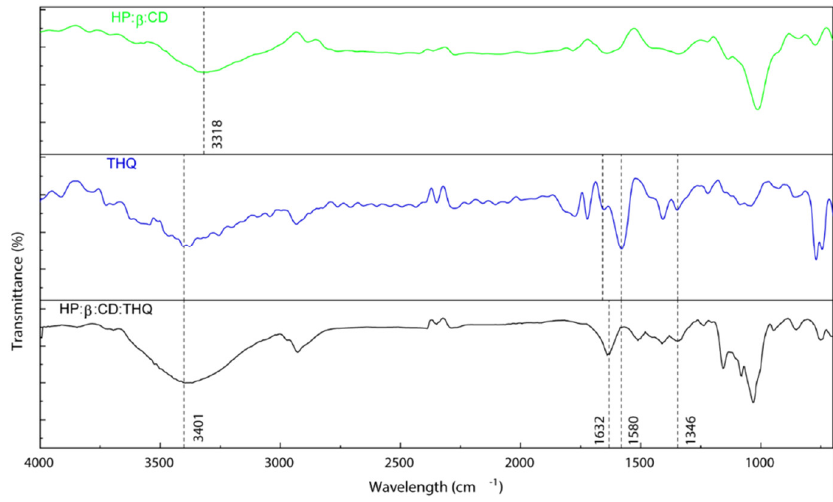
Figure 4. FTIR of controls HP β CD, THQ and sample THQ:HP β CD highlighting key peaks.